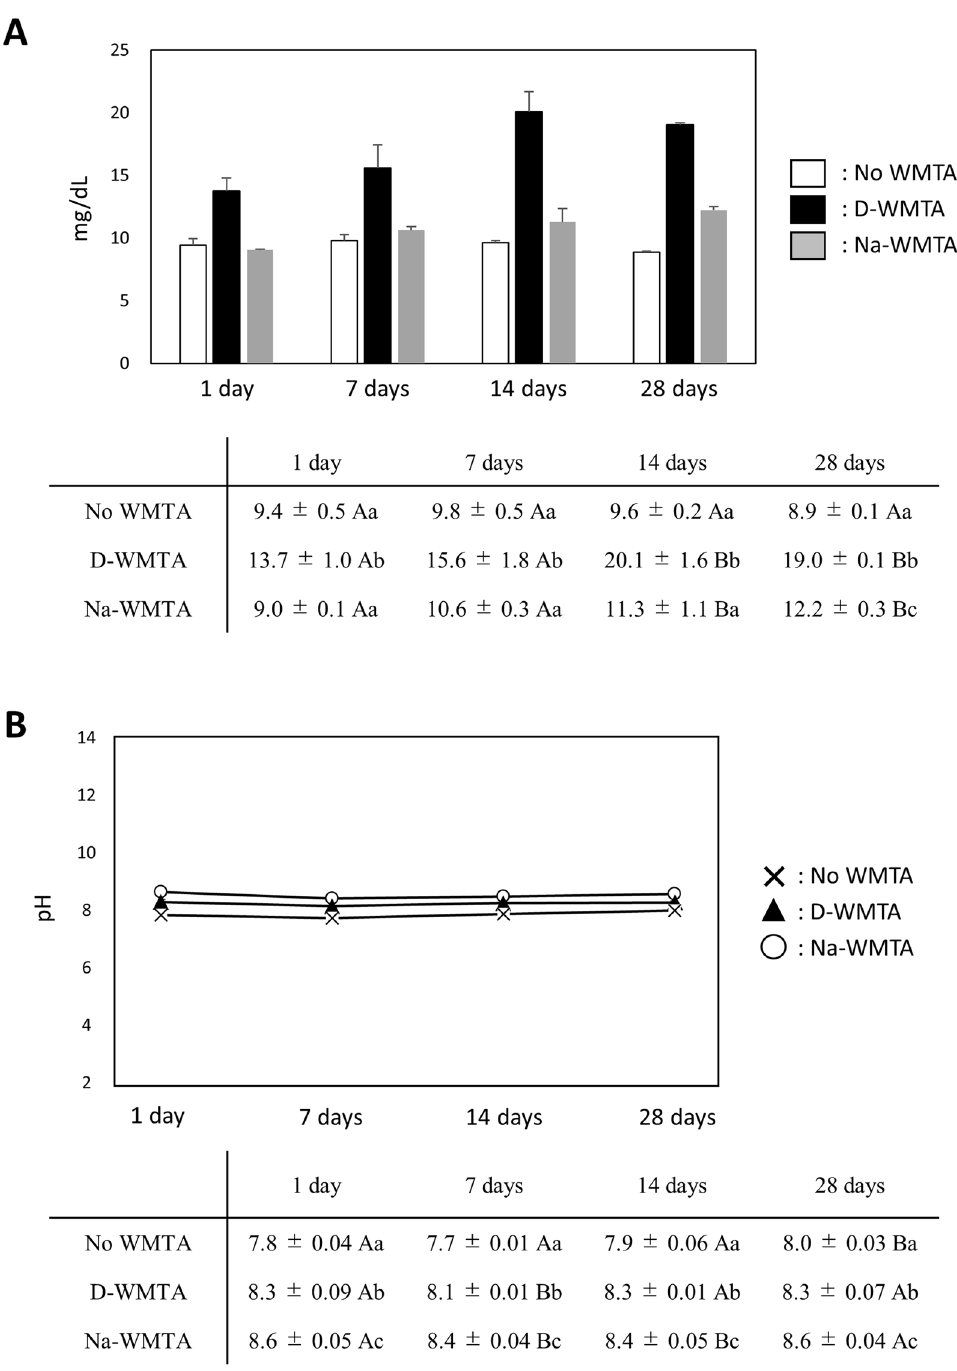
Figure 4. Effects of WMTA discs immersed in NaOCl on Ca 2+ release and pH. Ca 2+ amount ( A ) and pH ( B ) alteration in the medium. D-WMTA and Na-WMTA discs were immersed in CM for 1, 7, 14 and 28 days (n = 3 discs per time point). CM without WMTA discs (No WMTA) was used as a control. Different upper-case letters indicate statistically significant differences between WMTA discs. Different lower-case letters indicate statistically significant differences between time points. *P <